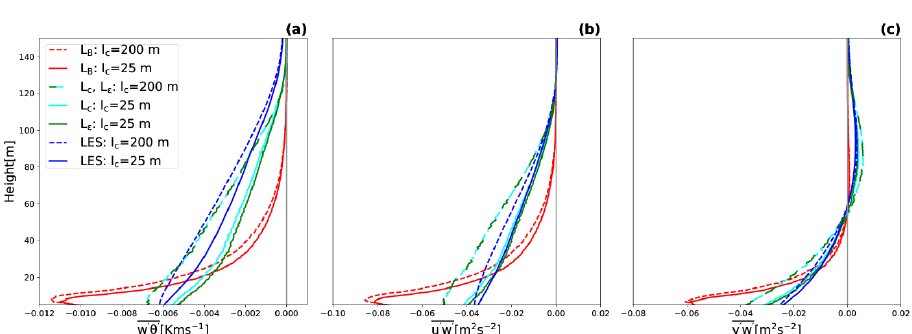
Figure 4. The turbulent heat flux ( a ) and the turbulent momentum fluxes ( b , c ) for GABLS1. The turbulent fluxes are computed according to the local down-gradient formulation (see Equations (27)–(29)) using the fit of the diagnosed turbulent length scale, L c , (cyan lines), fit of L (cid:101) (green lines), or the parametrized turbulence length scale according to Equation (18) in [16], L B , (red lines) for two sub-domain sizes (dashed lines versus solid lines). The turbulent fluxes acquired directly from LES are plotted with blue